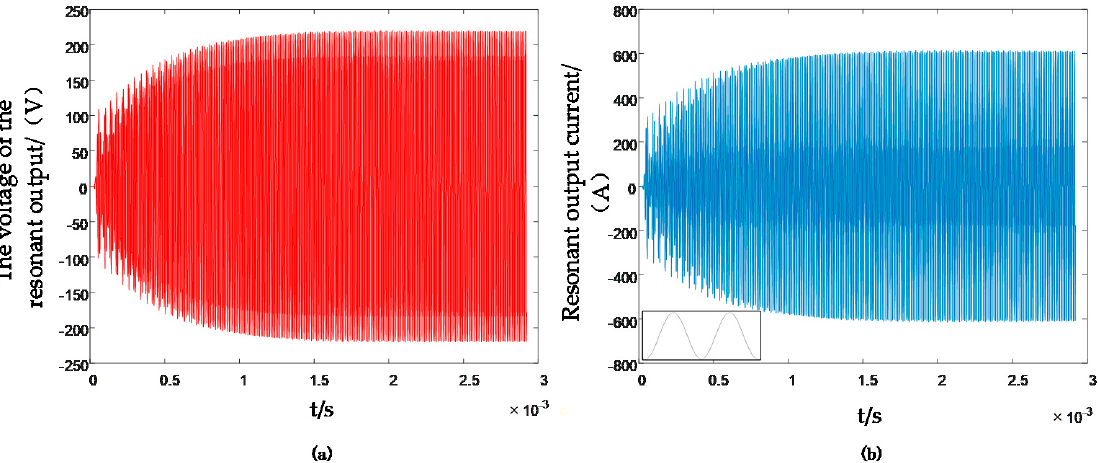
Figure 8. Resonant circuit output simulation plot: ( a ) simulation of the voltage output from the resonant circuit; ( b ) simulation of the current output from the resonant circuit.